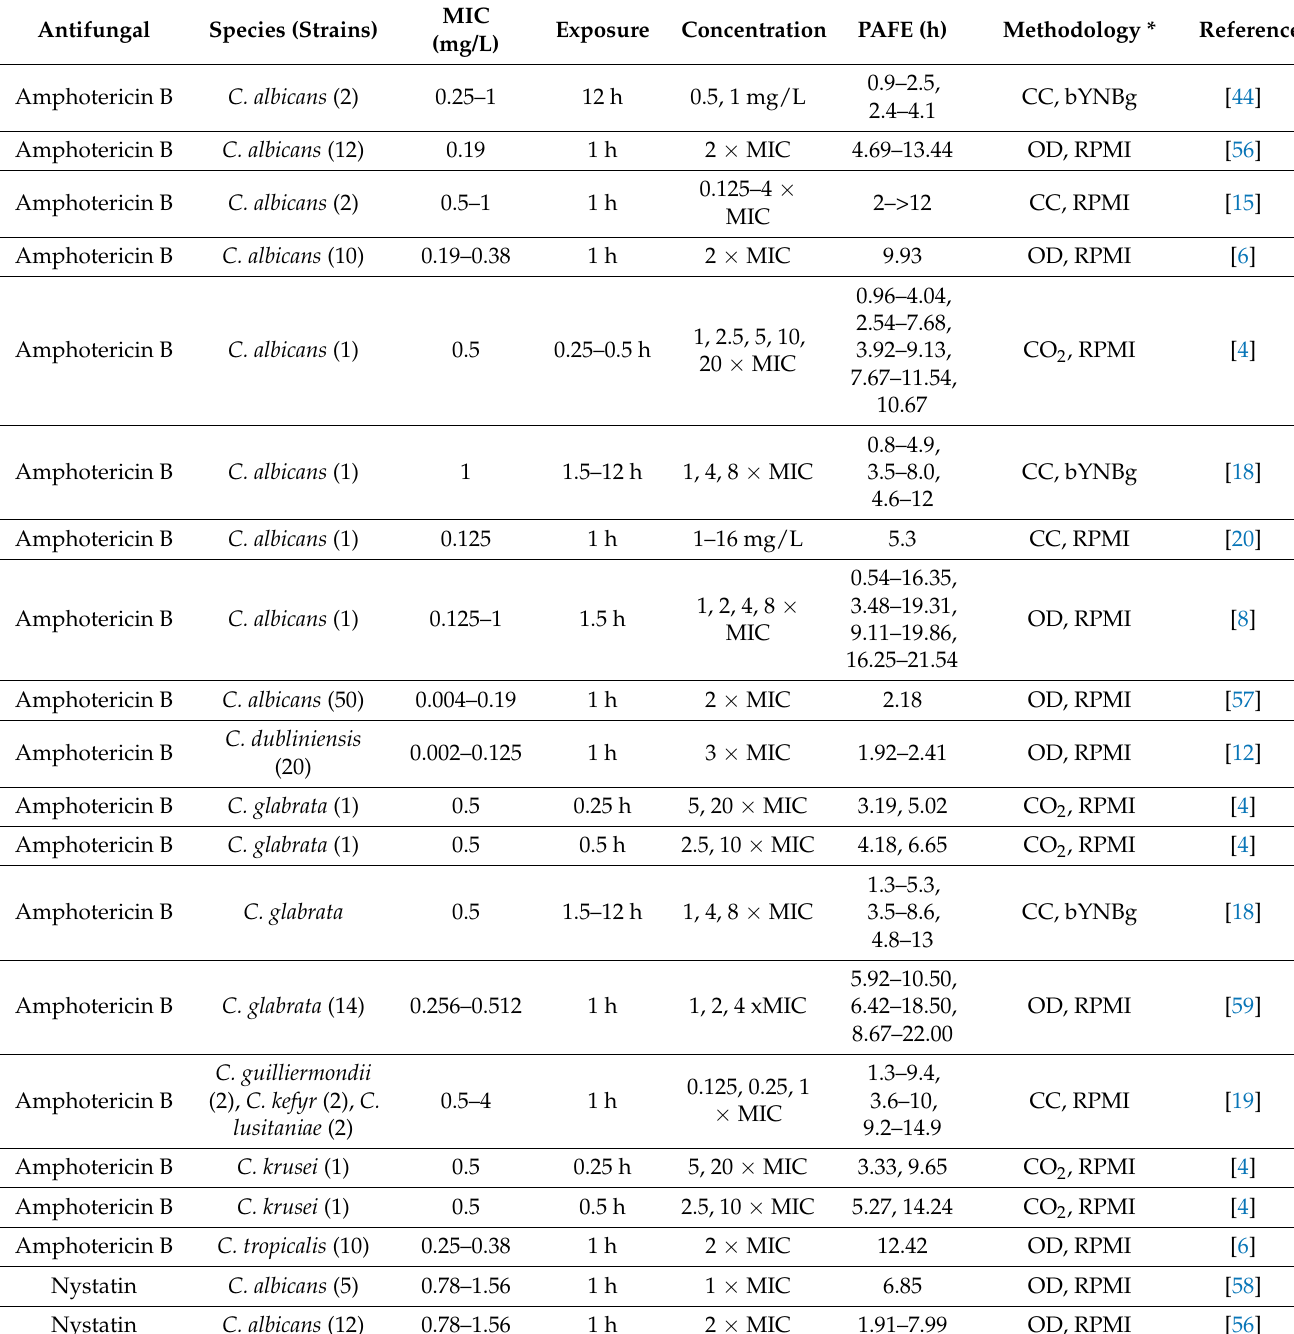
Table 1. PAFE in vitro of